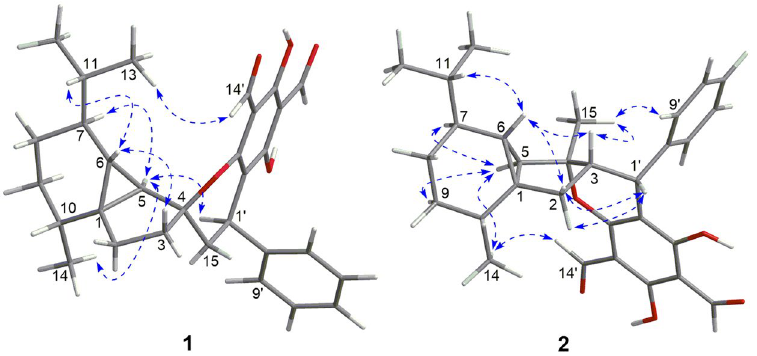
Figure 3. Selected NOESY correlations of 1 and 2 .